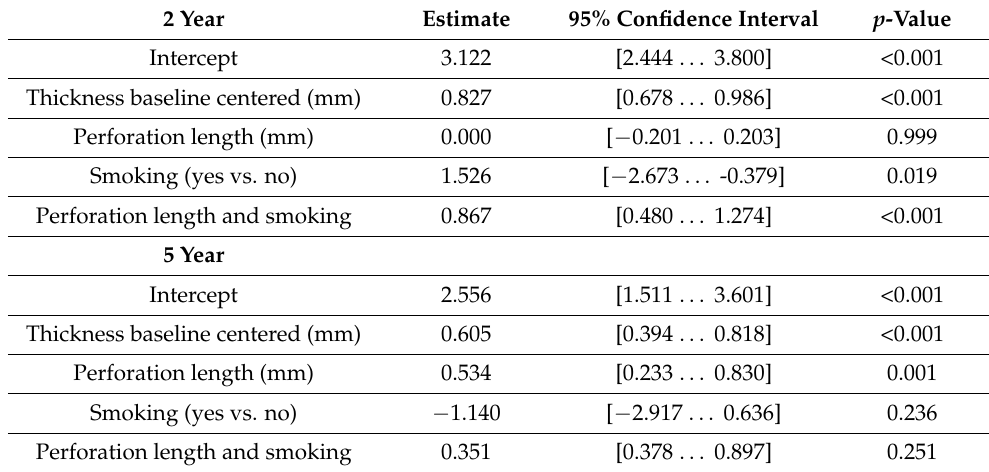
Table 3. Separate effect of baseline swelling (centered)/perforation length/smoking and combined effect of perforation length and smoking on membrane thickness after 2 and 5